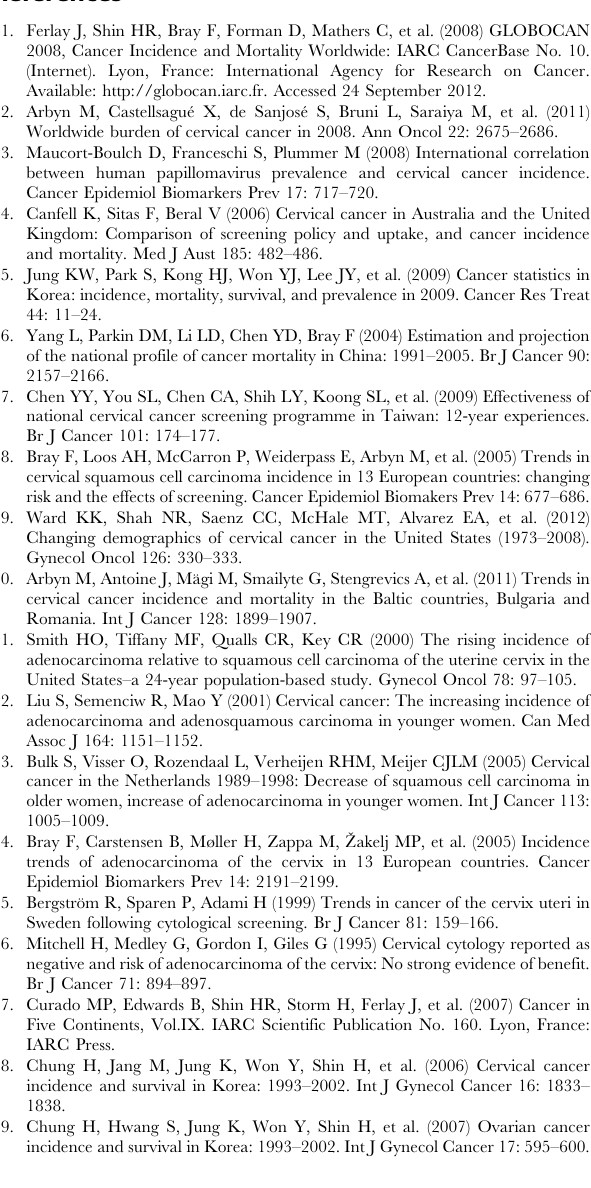
Figure S1 The association between screening rate for cervical cancer and incidence rate for carcinoma in situ, 1998–2009. Figure S2 The association between screening rate for cervical cancer and incidence rate for invasive cervical carcinoma, 1998–2009. Table S1 Age-standardized cervical cancer screening rates and annual percent change (APC) according to the age group in Korea,